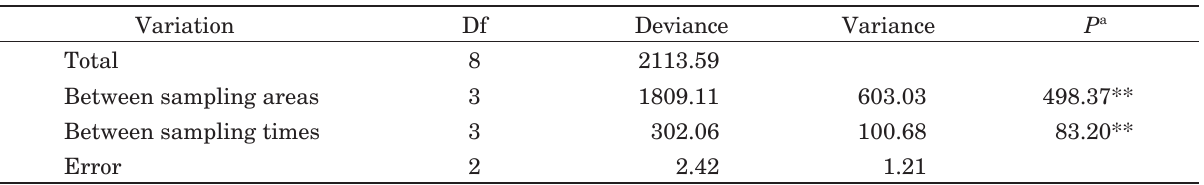
Table 2. ANOVA of the number of Apiognomonia quercina propagules released from Quercus cerris and Quercus pubescens trees.